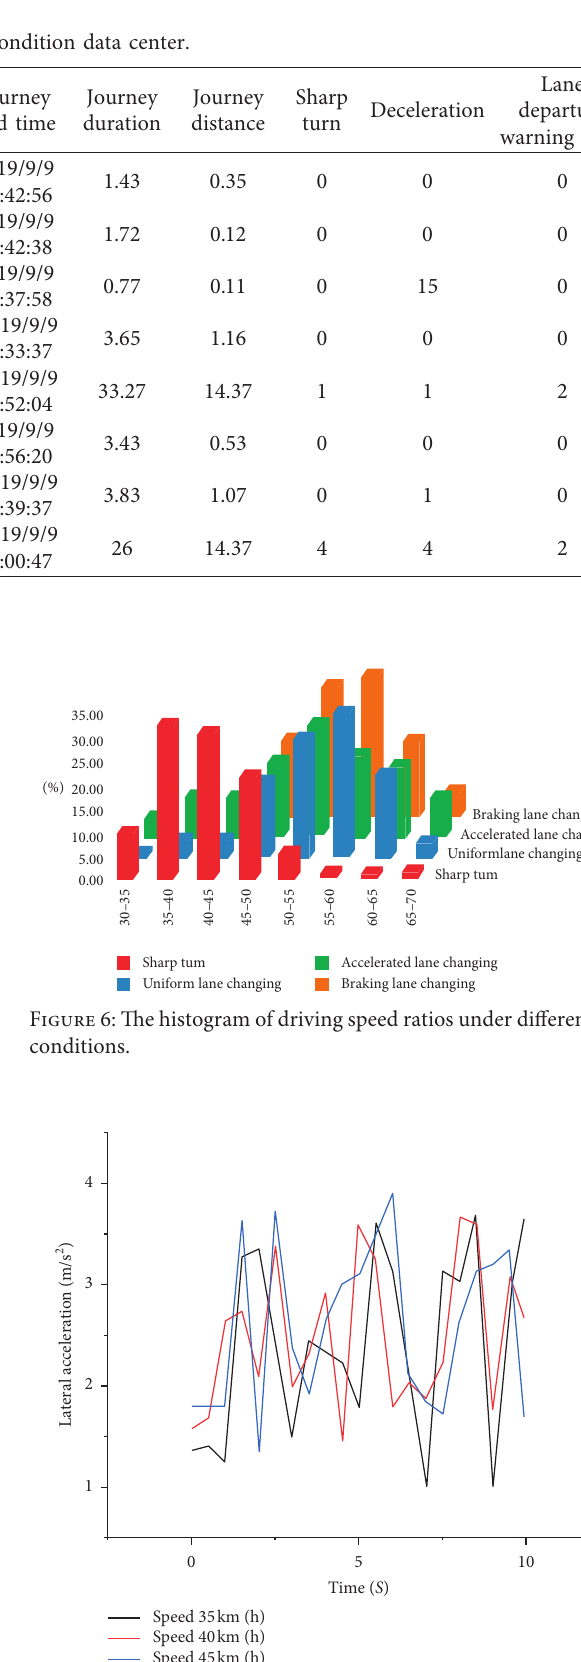
Figure 7: Lateral acceleration change of vehicle-turning